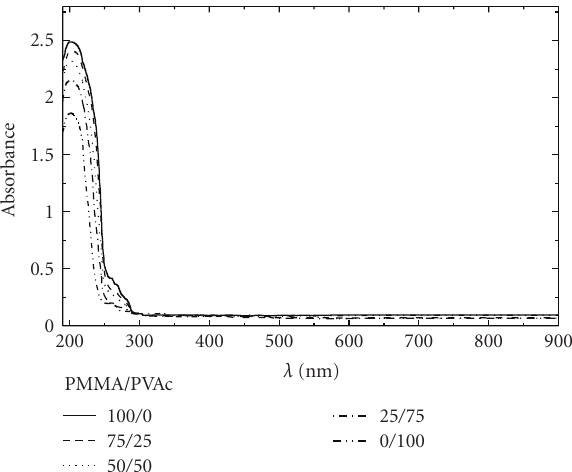
Figure 2: Absorption spectra of di ff erent concentrations of PMMA/PVAc blend before exposure to